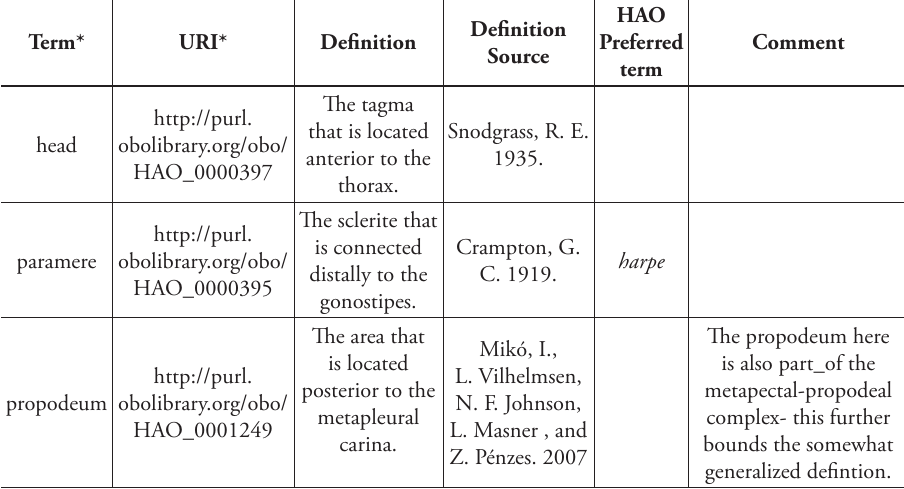
Table 2. An example URI table. Starred (*) columns are required. See discussion for